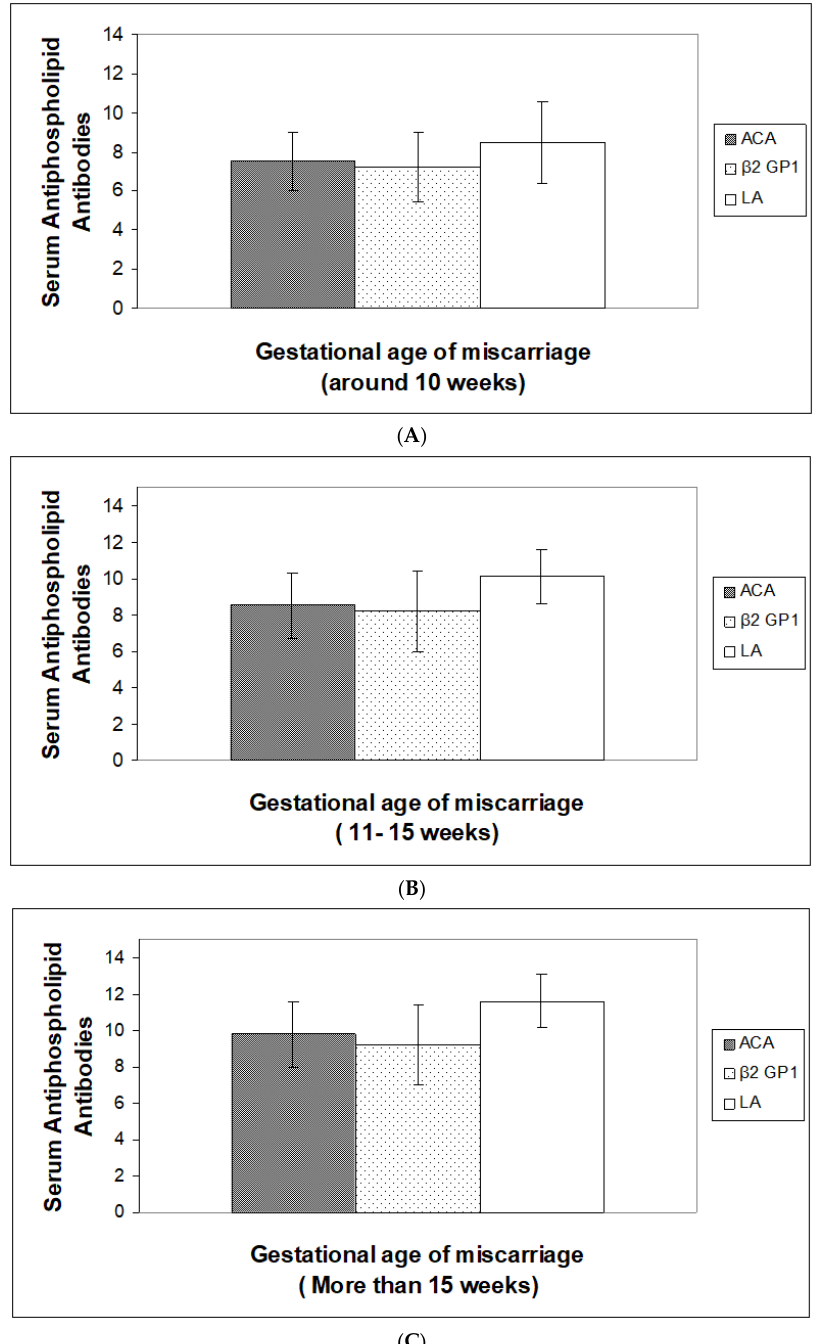
Figure 2. Estimation of anticardiolipin (ACA), anti- β2 -glycoprotein- 1 (β2 GP1) and Lupus anticoagulants (LA) in the case group of Saudi women. Values are Mean ± SD, ( n = 100), n = Total number of subject examinations.